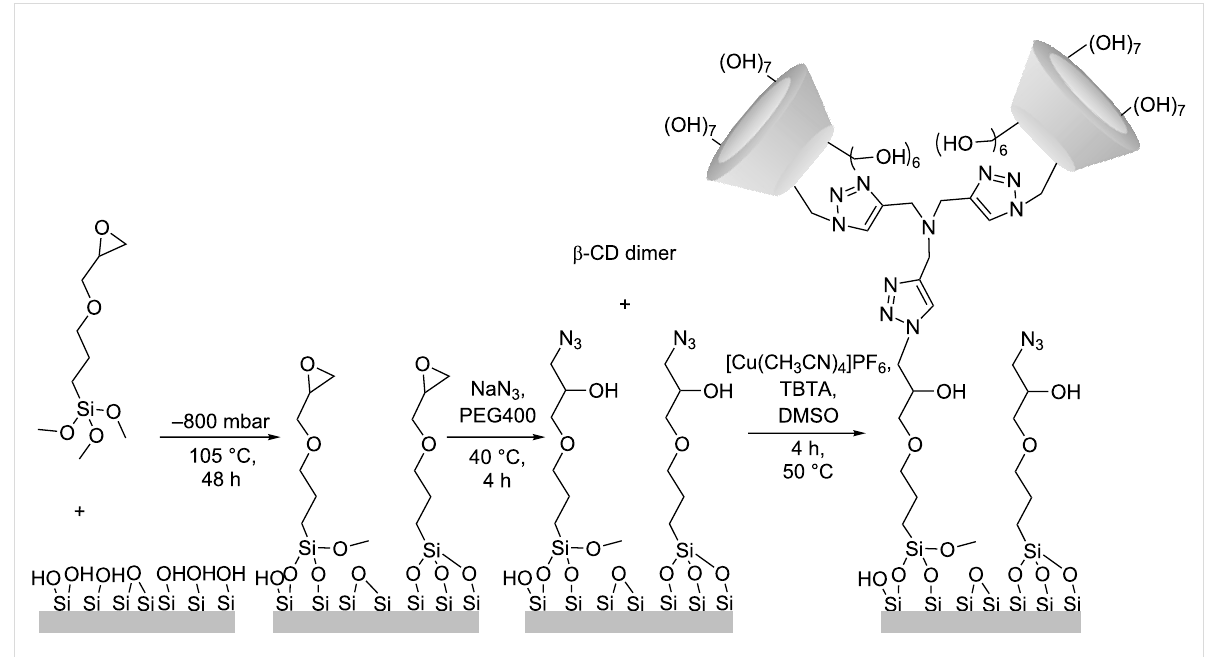
Scheme 2: Synthetic route for the activation of silicon dioxide surfaces and the grafting of the β -CD dimer through the free alkyne using CuAAC.